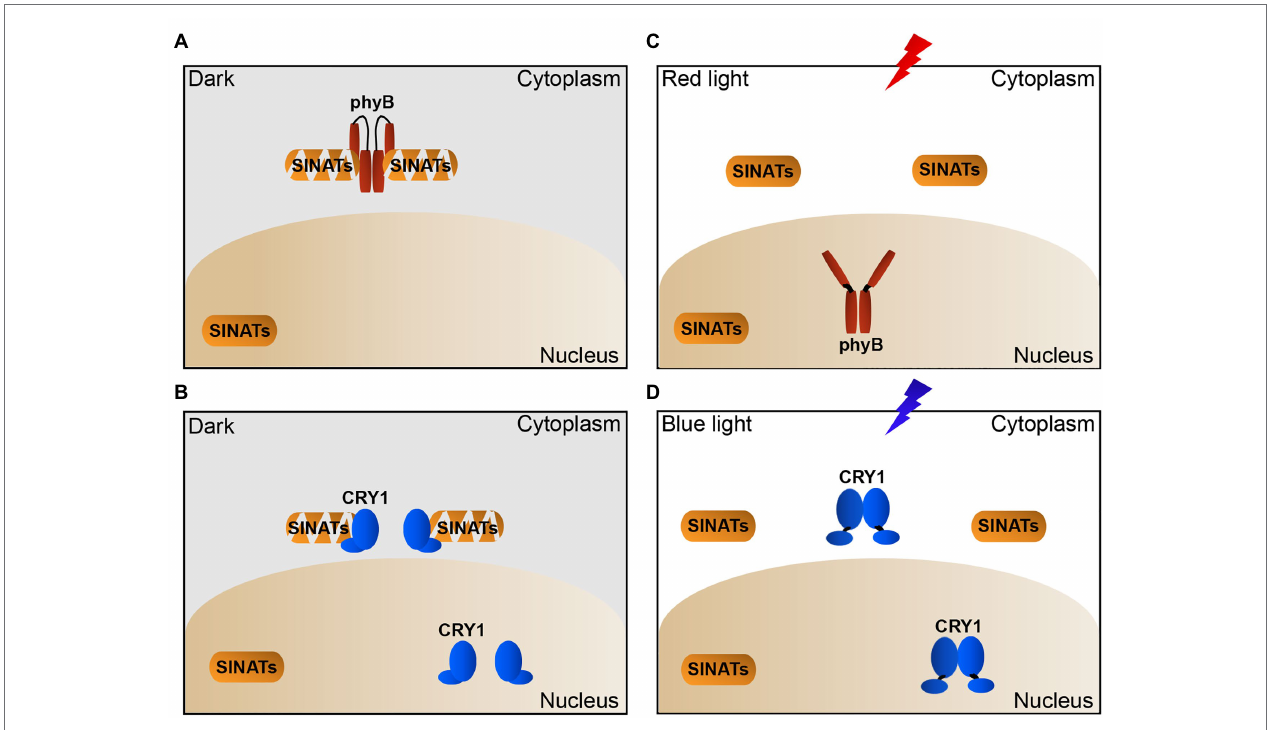
FIGURE 5 | Proposed model illustrating how light-induced dynamic changes of phyB and CRY1 promote the accumulation of SINATs in cytoplasm. (A,B) In the dark, phyB and CRY1 in cytoplasm interact with SINATs to promote their autocatalytic ubiquitination and degradation. (C) In red light, phyB undergoes conformational change and translocates to the nucleus and dissociates from the cytosolic SINATs, which leads to SINAT accumulation in the cytoplasm. (D) In blue light, CRY1 in cytoplasm is activated and lead to its dissociation from the cytosolic SINATs and the accumulation of SINATs in the